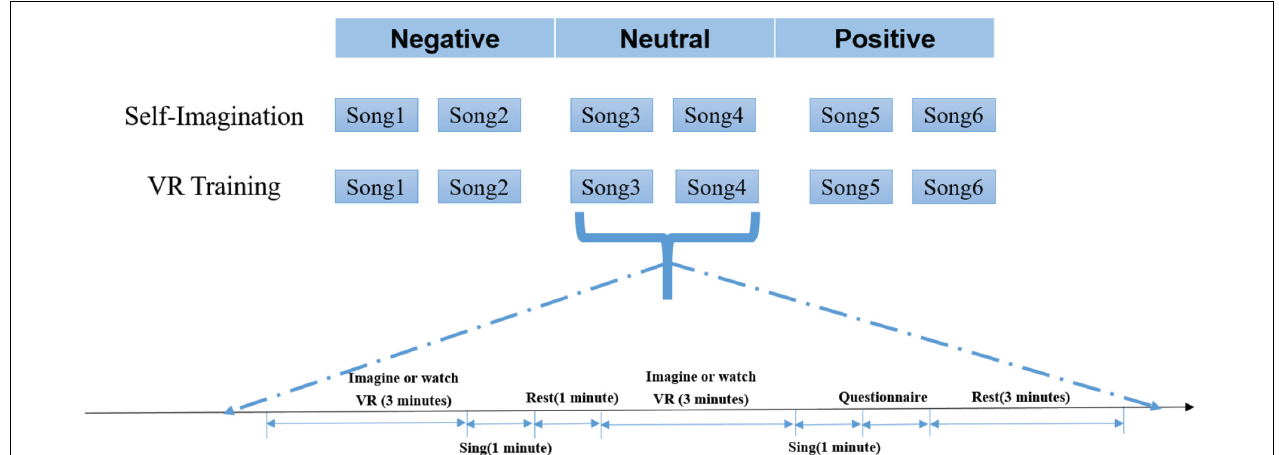
FIGURE 2 | Experimental